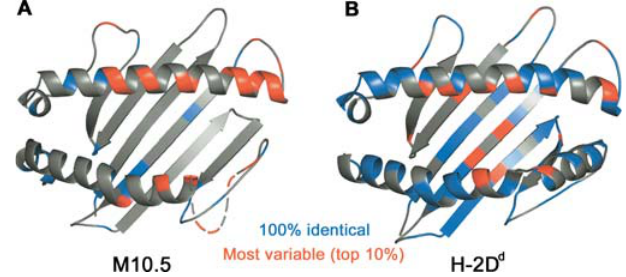
Figure 4. Sequence Conservation in M10 and H-2 Loci (A) Ribbon diagram of the M10.5 a 1– a 2 platform with positions of residues that are 100% identical in the nine M10 and M1 families colored blue; residues that are among the top 10% most variable are colored red. Variability is determined by the number of amino acids at a given position divided by the frequency of the most common allele at that position. Residues 145–150, which are disordered, are designated by a dashed line. (B) Ribbon diagram of the H-2D d a 1– a 2 domain. Conserved (blue) and highly variable (red) residues are derived from an alignment of 19 H-2D alleles [80]. DOI: